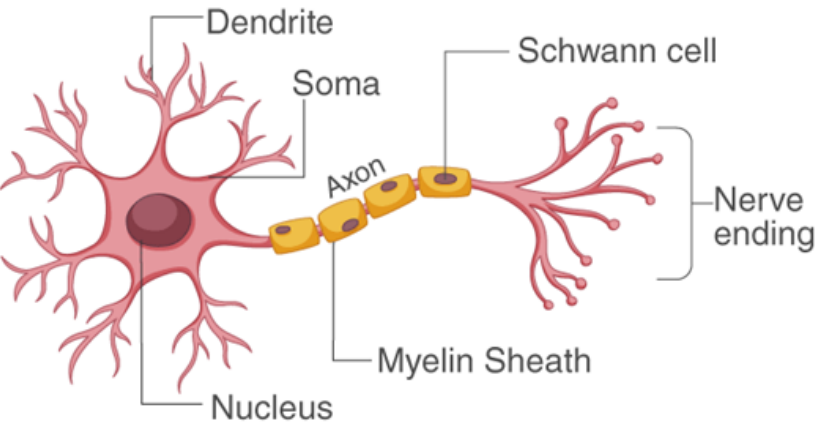
Figure 3. Structure of